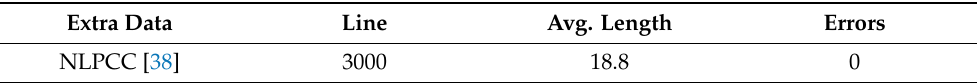
Figure 7. The F1 score of the model after the post-processing operation under different error rates (the percentage of error sentences in the text). Among them, the three colors represent different test sets. The figure’s left side is the index results of error detection, and the right side is the index results of error correction. The straight line results from the original model and the dotted line results from adding the post-processing operation. Table 4. Statistics information of the extra data. We selected 3000 sentences from the 2018NLPCC competition’s training set.